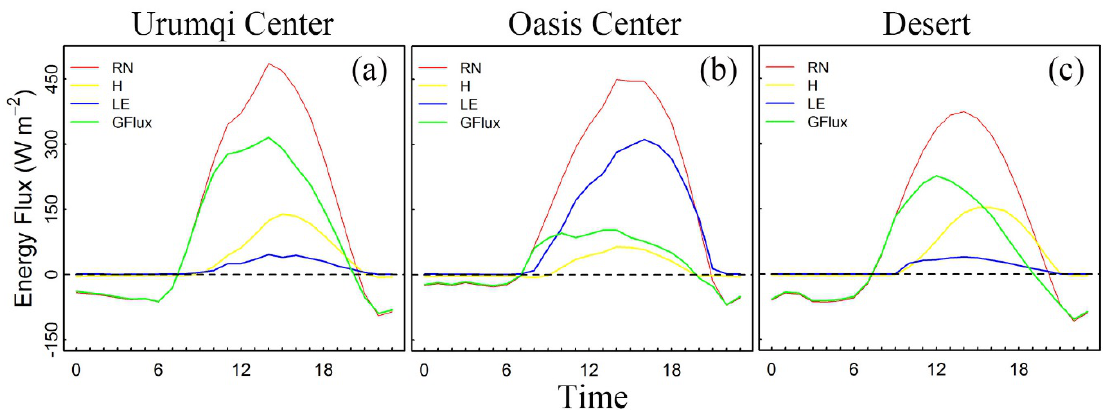
Figure 10. The diurnal variation of the surface energy flux on the 11 June 2016 computed from the CTL simulation at Urumqi city center ( a ), oasis center ( b ) and a grid point representing the desert ( c ). RN: net radiation; H: sensible heat; LE: latent heat; GFlux: soil heat flux. Note that the sign convention is positive-downwards (negative flux is cooling the surface).